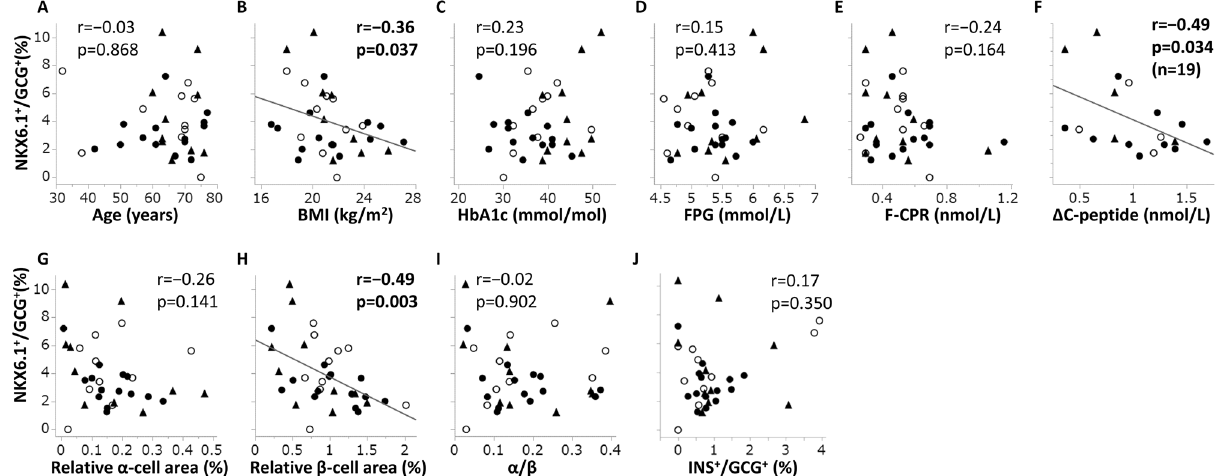
Figure 1. Correlation coefficients between the NKX6.1-positive ratio of glucagon-positive cells and various parameters. NKX6.1-positive ratio of glucagon-positive cells (NKX6.1 + /GCG + ratio) and age ( A ), BMI ( B ), HbA1c ( C ), FPG ( D ), F-CPR ( E ), ΔC-peptide ( F ), relative alpha-cell area ( G ), relative beta-cell area (H), α/β ( I ), and INS + /GCG + ratio ( J ). Closed circles ( ), normal glucose tolerance; open circles ( ○ ), impaired glucose tolerance; closed triangles ( ▲ ), diabetes; NKX6.1 NK homeobox 6.1, FPG fasting plasma glucose, F-CPR fasting ● C-peptide immunoreactivity, ΔC-peptide increment of C-peptide by glucagon test, α/β alpha- to beta-cell area ratio, r correlation coefficient, p p